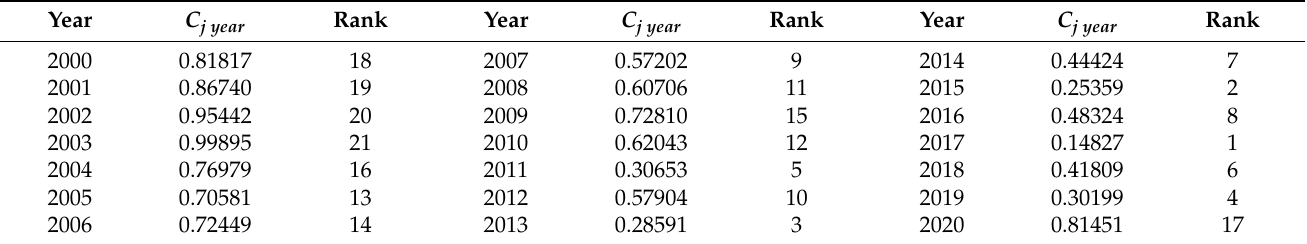
Table 6. Values and ranking of annual systematic risk factor.